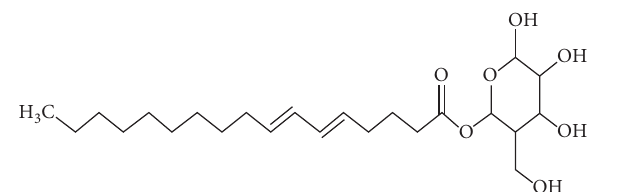
Figure 3: The structure of (5E,7E)-4,5,6 trihydroxy-3-(hydroxymethyl)tetrahydro-2H-pyran-2-ylheptadeca-5,7-dienoate (compound 2).